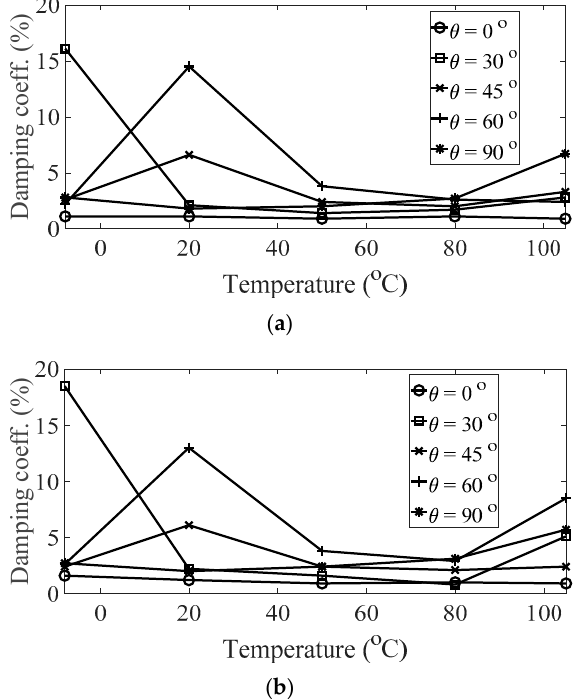
Figure 11. Variation of damping coefficient ( ξ 1 ) according to different temperature conditions: ( a ) p = harmonic and ( b ) p = random.